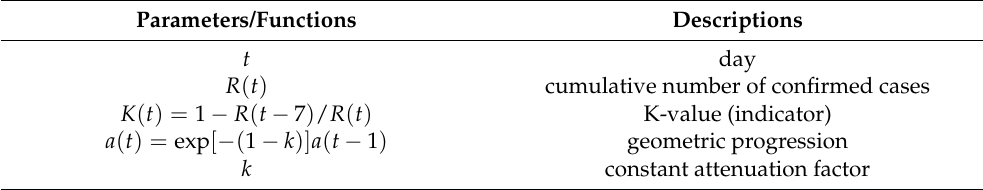
Table 1. The parameters and functions for the K-value and phenomenological constant attenuation model.